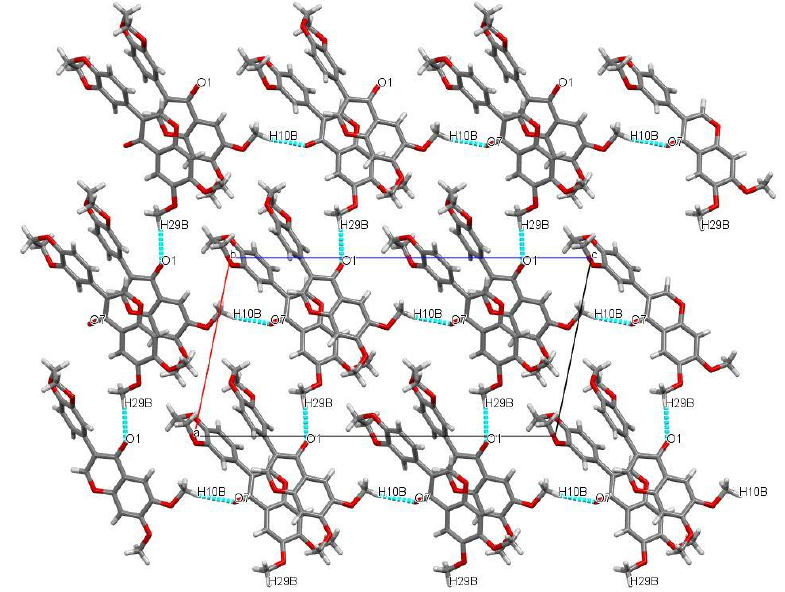
Figure 5. A view along the b axis of the crystal packing of compound 5 . The molecule I and II are linked via intermolecular hydrogen bonds C11 – H11B···O12 and C29 – H29B···O1. For clarity, the hydrogen atoms not involved in H bonds are omitted. Table 3. Intermolecular hydrogen bonds involved in the crystal packing of compound 5 (Å and °).